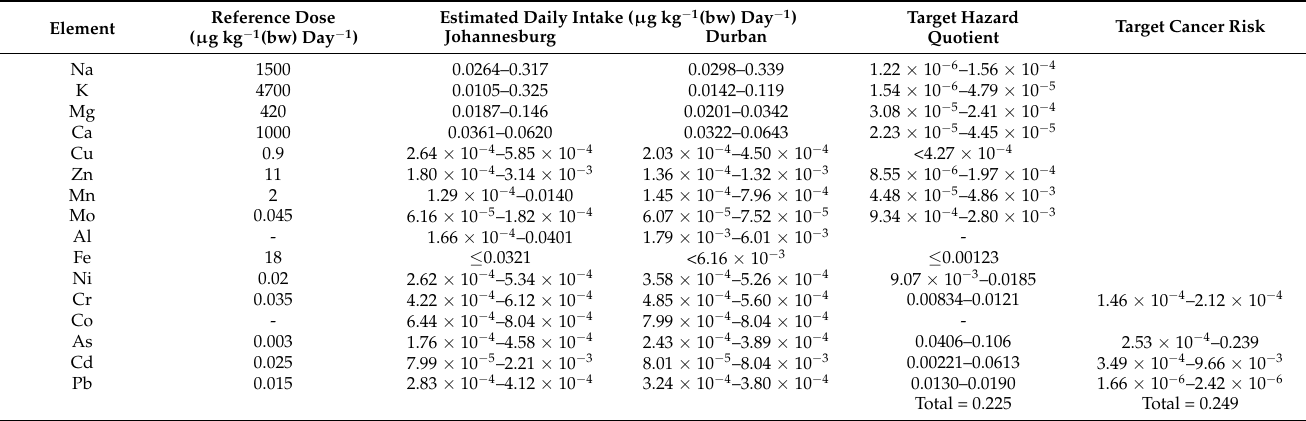
Table 2. Aphrodisiac metal ion consumption rates and health risk